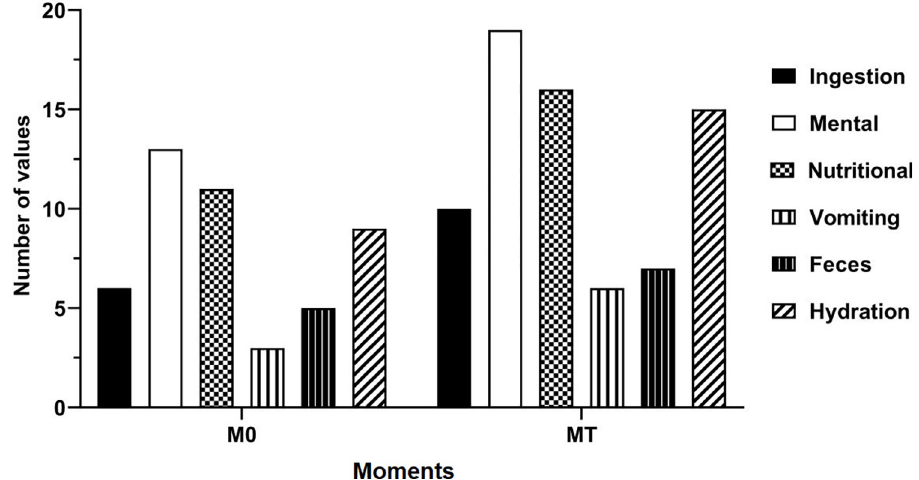
Fig 1. Clinical score plot of dogs with stage IV CKD submitted to intermittent hemodialysis (IHG) at the first- and last-moments.